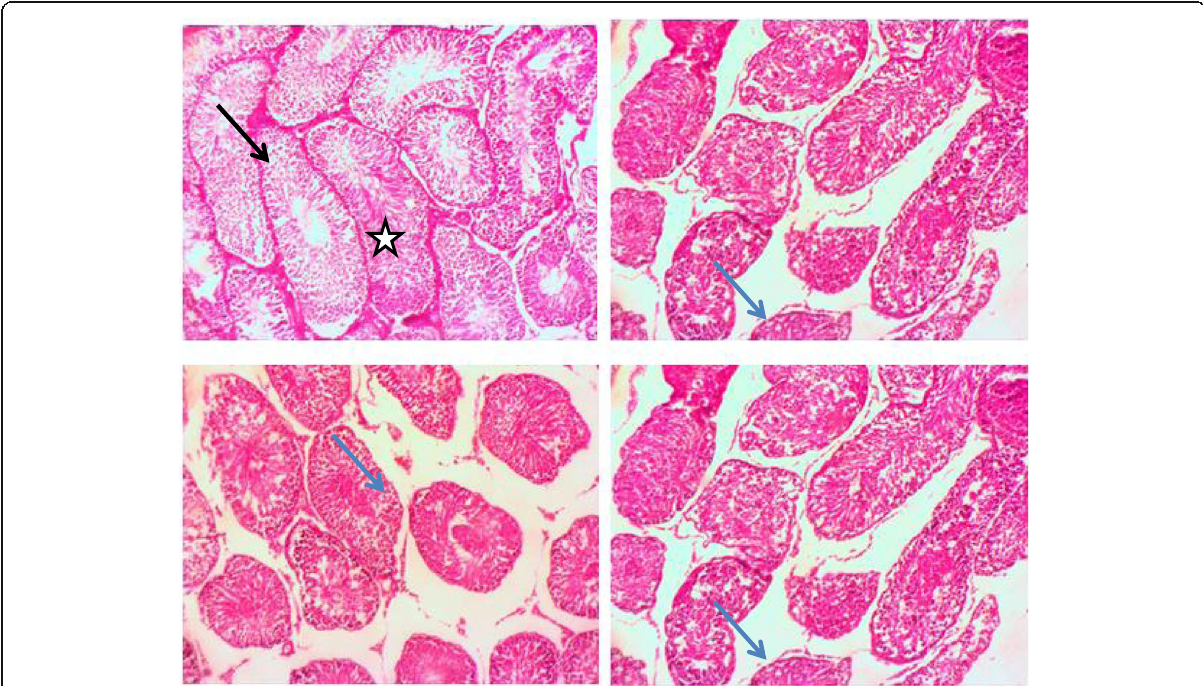
Fig. 1 Photomicrographs of the testis of male Wistar rats exposed to different doses of dichloromethane soluble fraction of WILR. Control (C): normal testis showing the seminiferous tubules (star) and interstitium (black arrow). 200 μ g/kg (DA): loss of interstitium (blue arrow) and germ